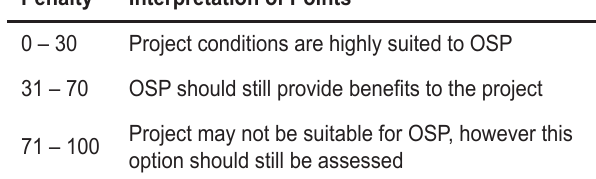
Table 5: Simple advice given in the toolkit for cumulative penalty